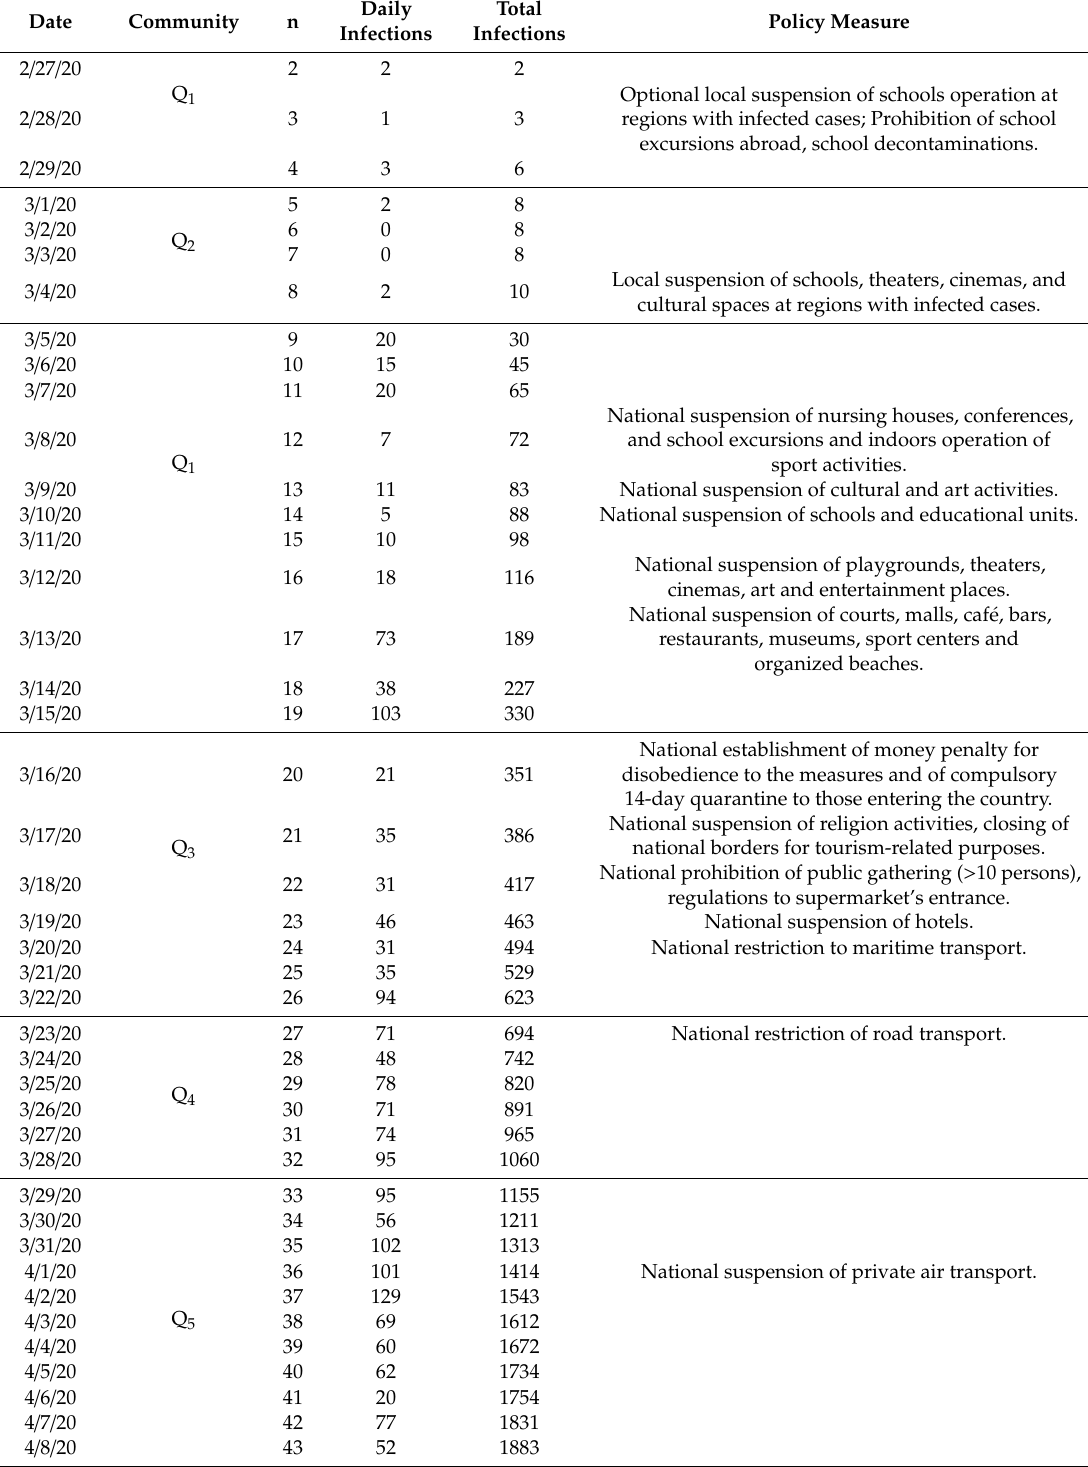
Table A1. The evolution of major Greek anti-COVID-19